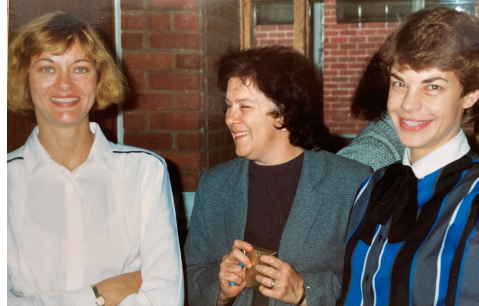
Figure 2: Kieka Mynhardt, Henda Swart, and Ortrud